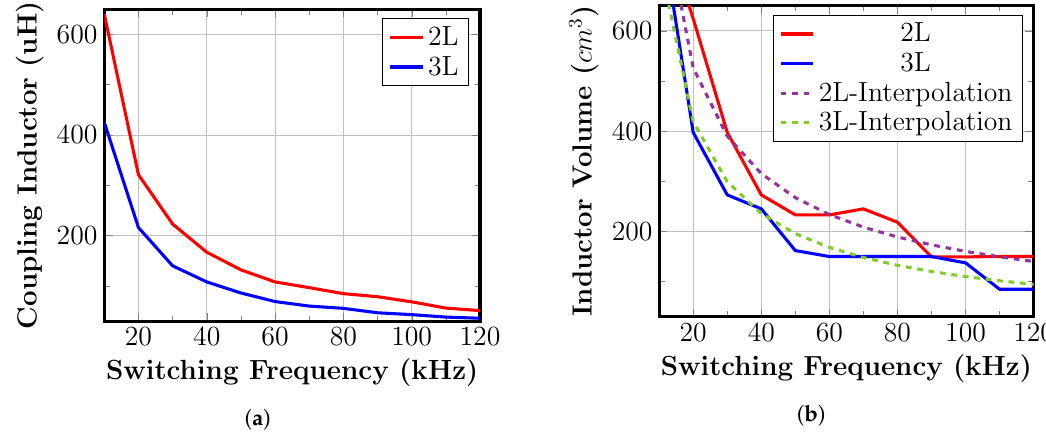
Figure 10. ( a ) Coupling inductor value function of the switching frequency for the 2L and the 3L topologies ( b ) Coupling inductor volume function of the switching frequency for the 2L and the 3L topologies